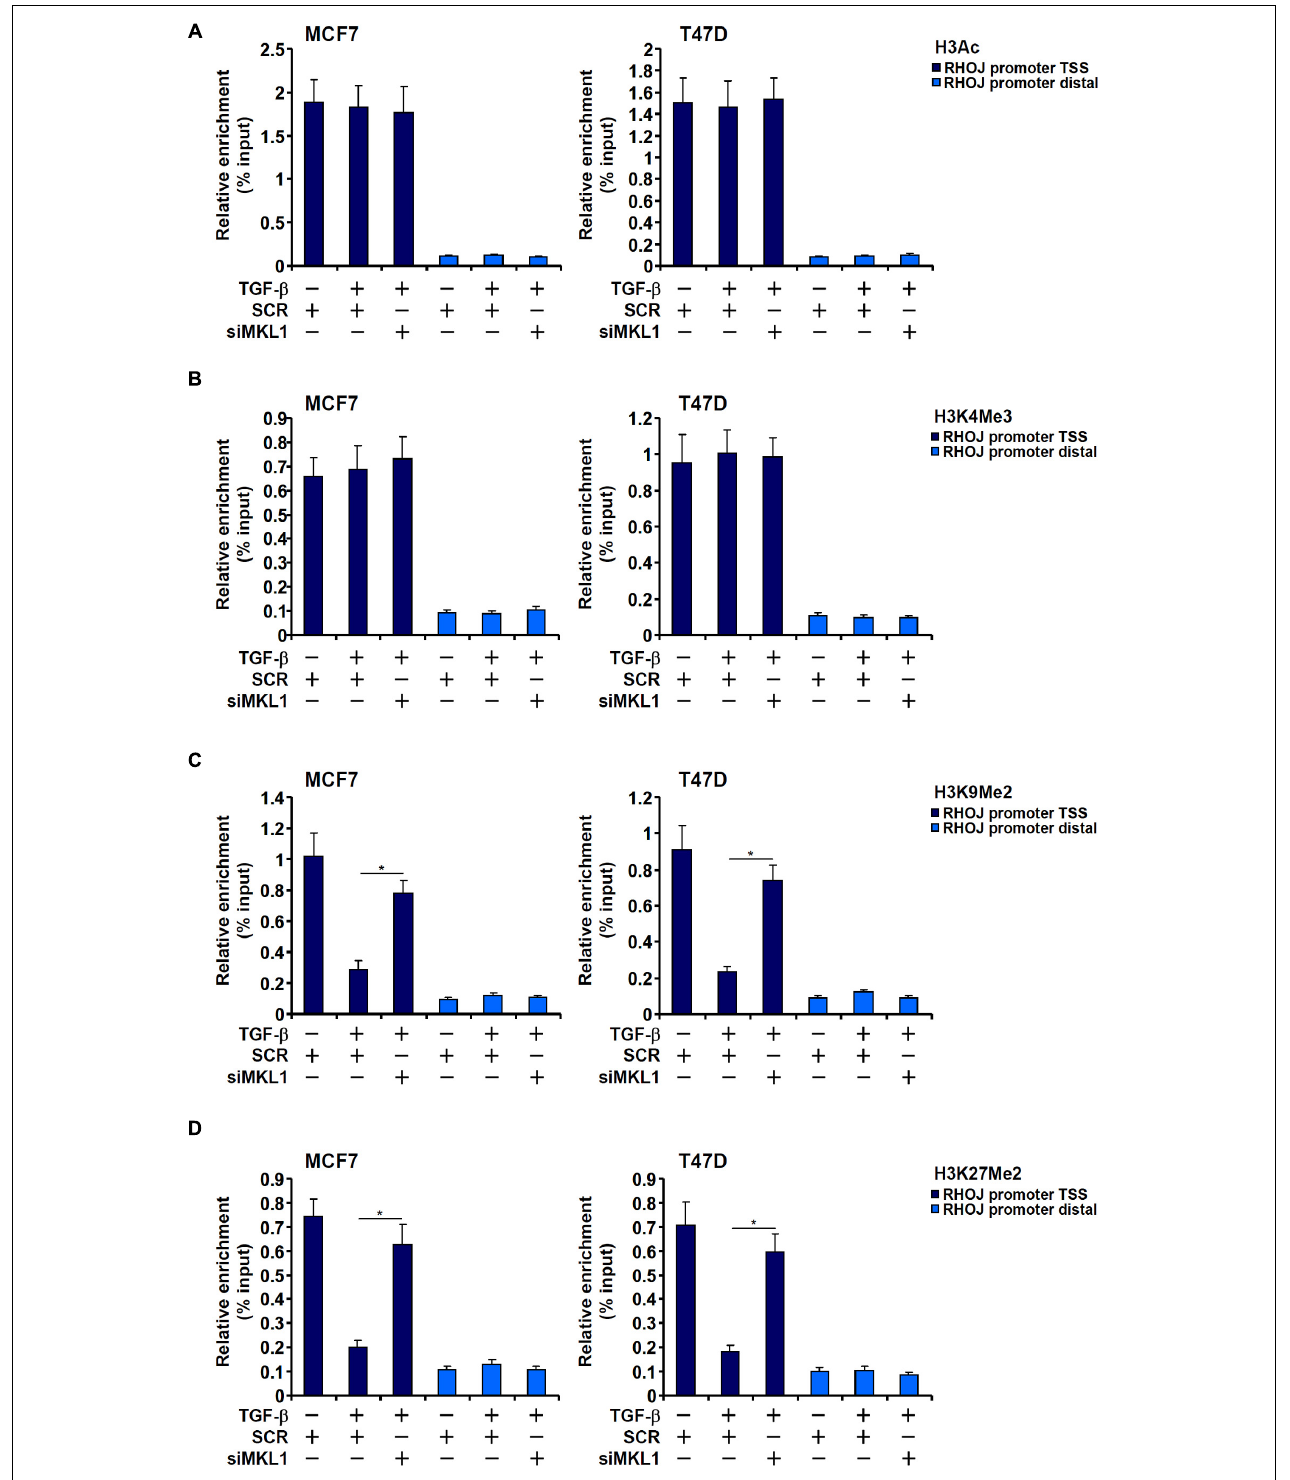
FIGURE 2 | H3K9 dimethylation and H3K27 dimethylation explain differential RHOJ expression. (A–D) MCF7 (left panel) and T47D (left panel) cells were transfected with indicated siRNAs followed by treatment with TGF- β for 48 h. ChIP assays were performed with anti-H3Ac (A) , anti-H3K4Me3 (B) , anti-H3K9Me2 (C) , and anti-H3K27Me2 (D) . All experiments were performed in triplicate wells and repeated three times, and one representative experiment is shown. Data represent mean ± SD. * p < 0.05, two-tailed t -test. MKL1 depletion partially restored H3K9/H3K27 dimethylation without altering H3 acetylation or H3K4 trimethylation on the RHOJ